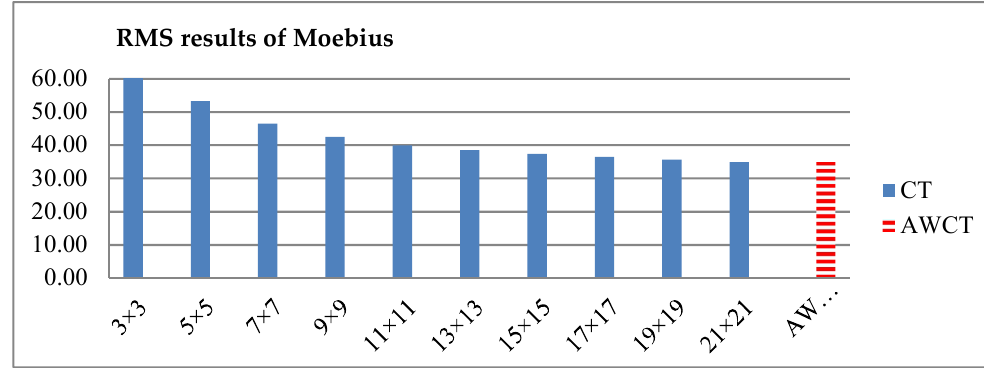
window size in ( b ) 13 × 13, ( c ) 15 × 15, ( d ) 17 × 17, ( e ) 19 × 19, and ( f ) 21 × 21.